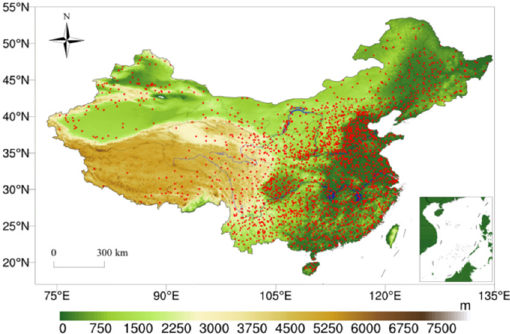
Figure 1. Generalized topography of China and distribution of the national meteorological stations considered in this study. Table 1. Information regarding the CMIP6 models’ name, institute/country, and horizontal resolution used in this study, where lat (lon) meaning latitude